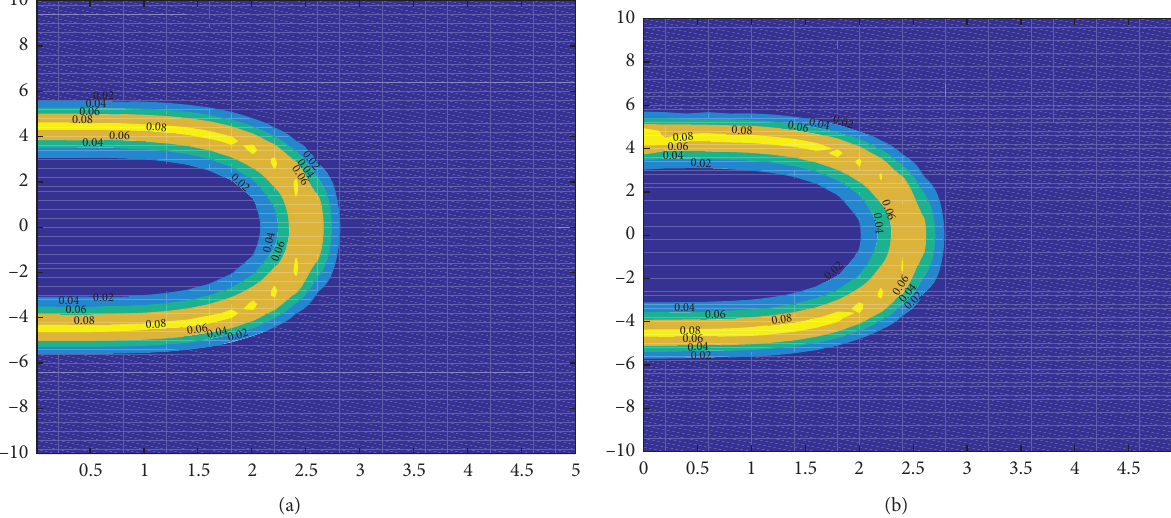
Figure 4: Contour plots of stationary joint PDFs for displacement x